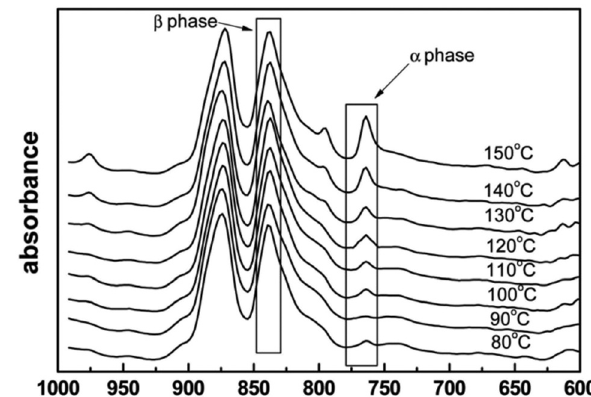
Figure 3: Calculation of the relative β - phase content from FTIR spectra [ 23 ]